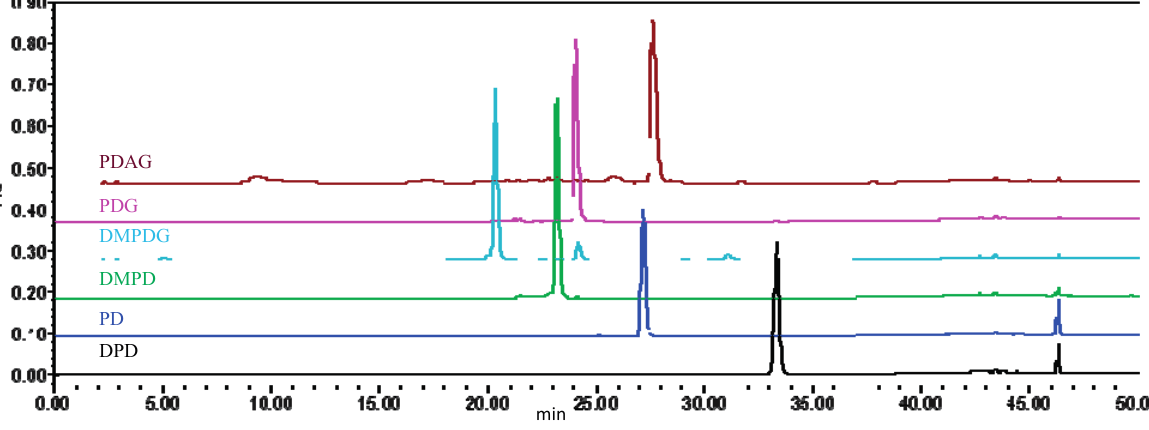
Figure 4. Representative HPLC chromatograms of six aryltetralin lactone